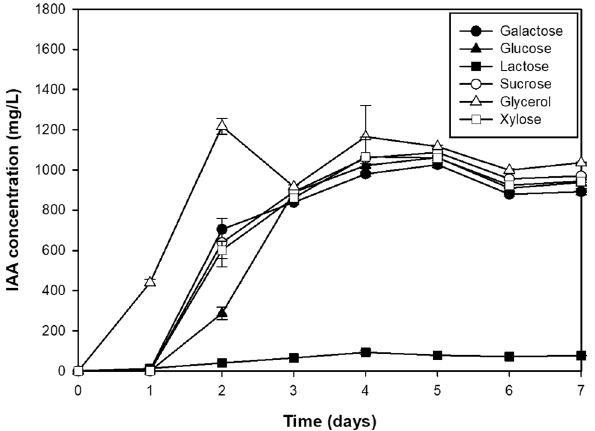
Figure 1. IAA production with various carbon sources by R. fluvialis DMKU-CP293 using YPD base medium (2% carbon source, 2% peptone, 1% yeast extract and 0.1% l-tryptophan) in shake-flask culture at 30 °C and 200 rpm for 7